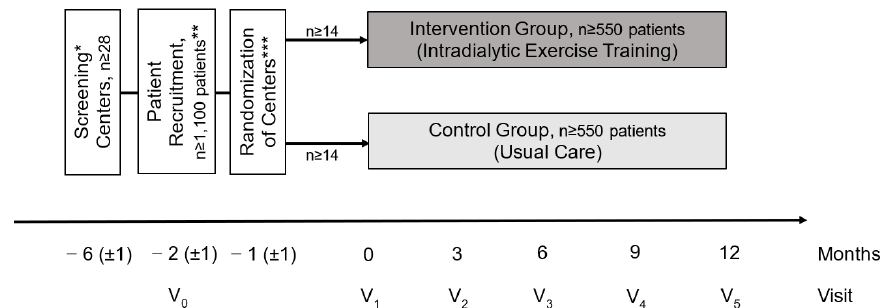
Figure 1. Study design of the DiaTT trial, including study visits (V). * From all the KfH dialysis centers in five regions in Germany, 28 will be recruited. ** In these centers, patients will be screened for eligibility (inclusion/exclusion criteria, informed consent) and included in the study (V0 screening). *** Centers will be randomized (1:1) to Intervention Group and Control Group. Visits will be at baseline (V1) and after 3, 6, 9 and 12 months (V2–V5).